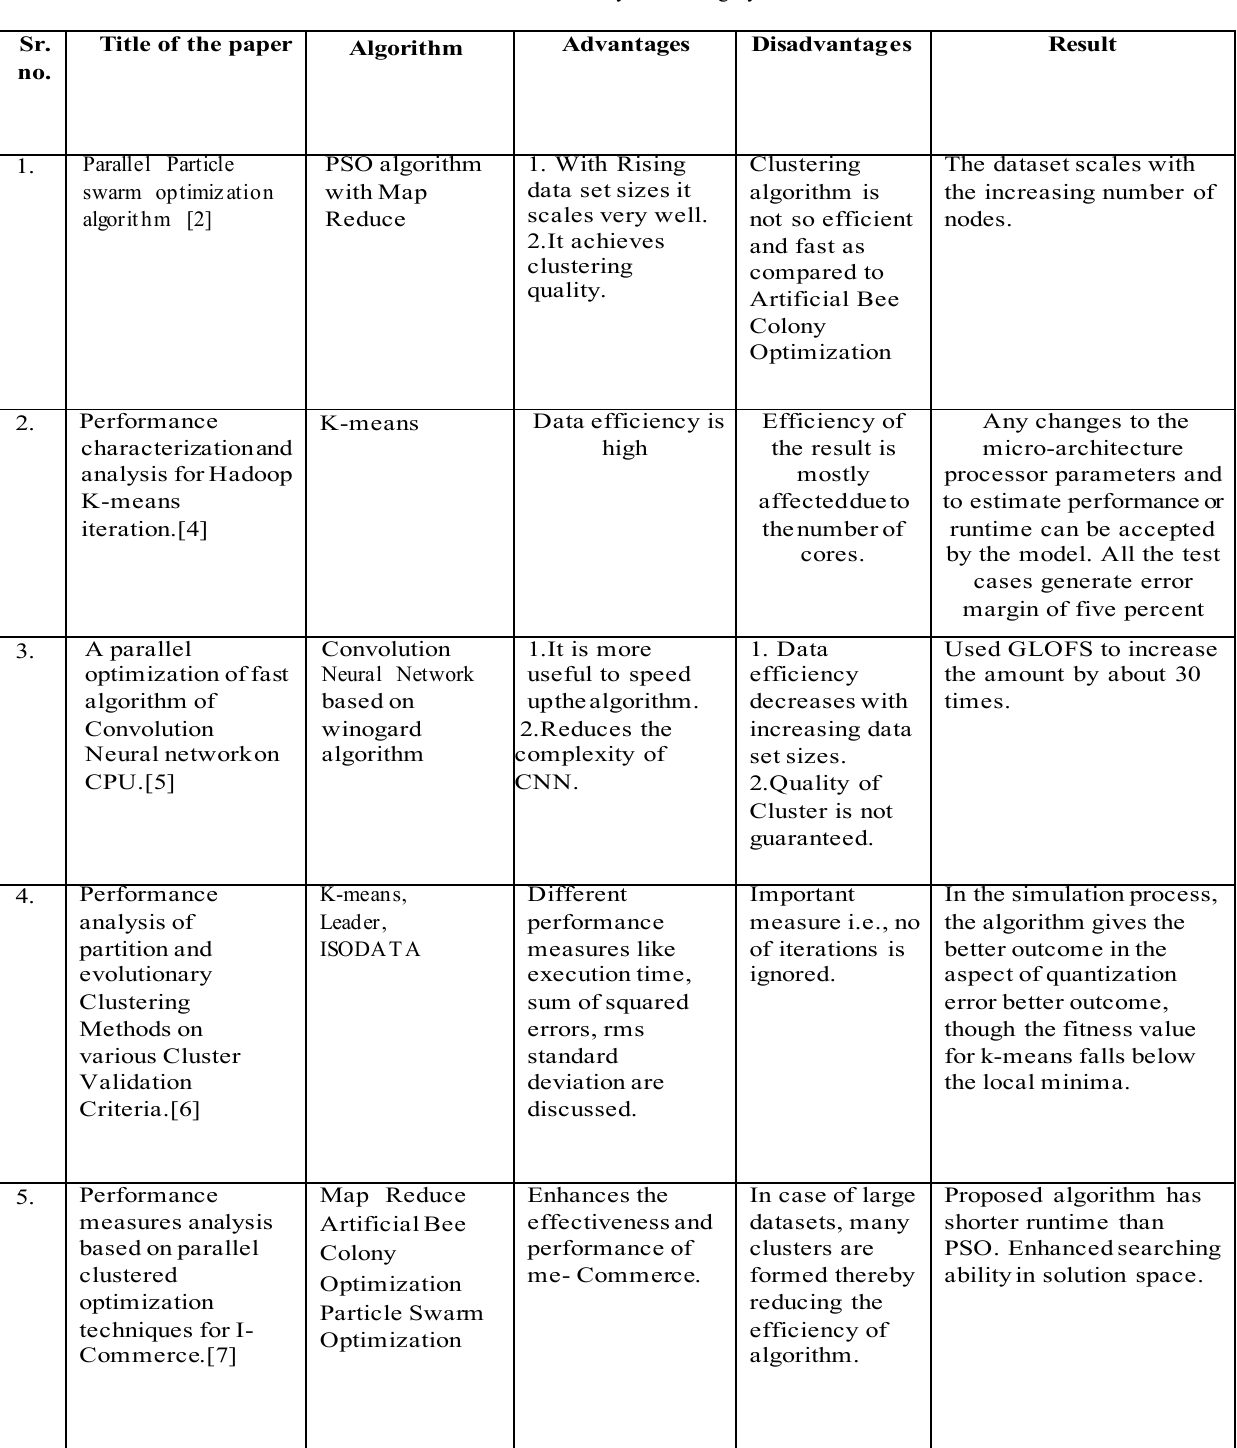
Table 1. Survey of Existing